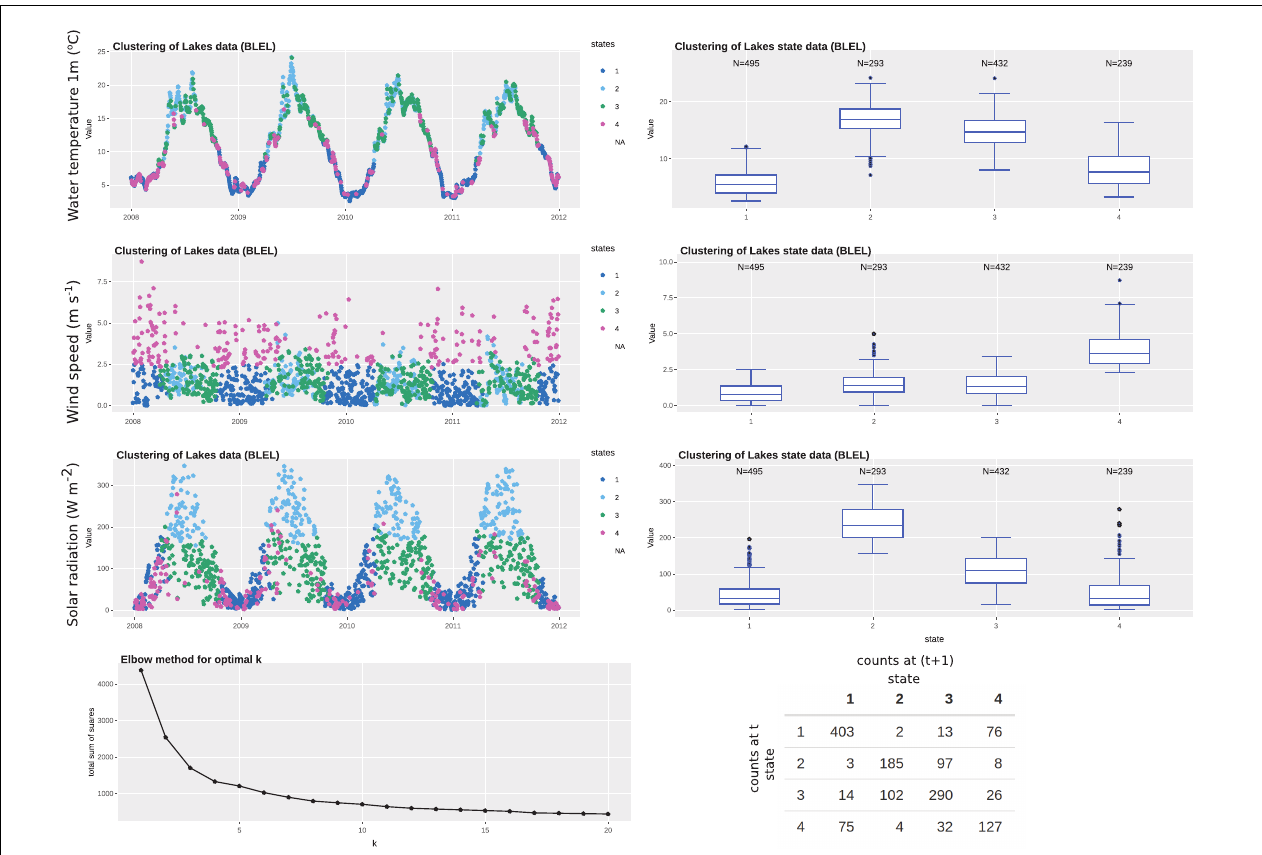
FIGURE 5 | Example of state tagging at the lake ecosystems site of Blelham Tarn. A box-and-whisker plot is linked to the time series and shows the statistics of the selected state variable for each cluster. An elbow plot is useful to optimize the number of clusters used and avoid overfitting. A t vs. (t+1) matrix is useful to explore the autocorrelation of